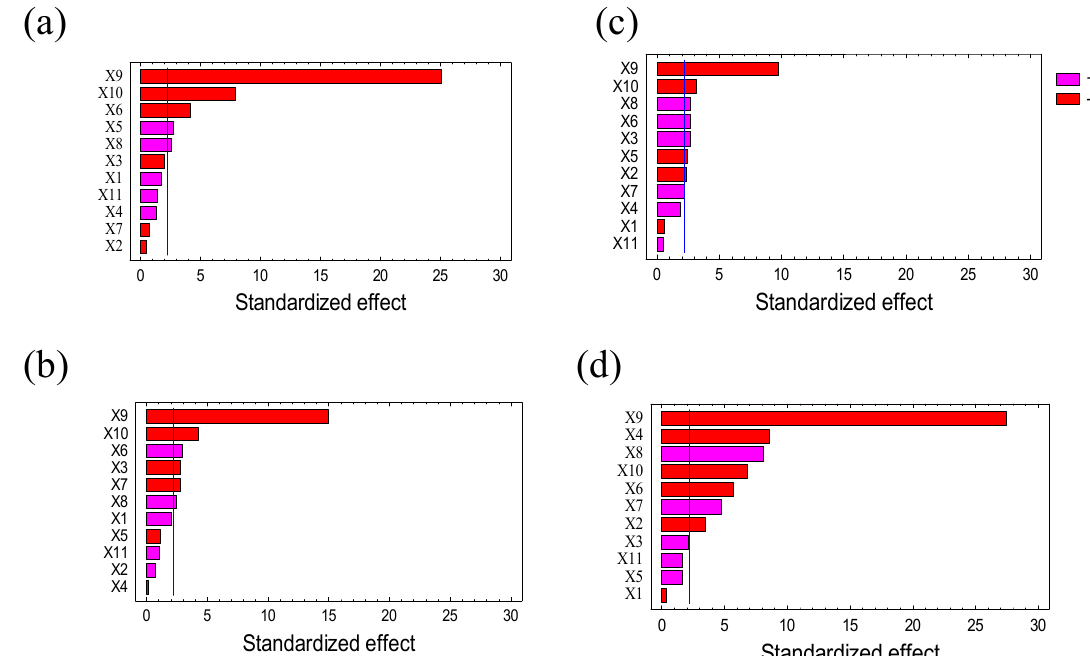
Figure 1. Standardized Pareto graph showing effect of the type of solvent, X1; the composition of solvents mixture, X2; the ratio of sample/solvent, X3; the concentration of Urea, X4; the extraction temperature, X5; the extraction time, X6; stirring speed, X7; pH, X8; type of salt, X9; concentration of salt, X10; and centrifugation speed, X11 on: ( a , b ) concentration of protein and ( c , d ) inhibition of amylase activity for Julius and Ponticus, respectively. The blue vertical line indicates the limit of the standardized effect whose values are significantly different from zero at the 95.0% confidence level. The pink color shows that the parameter has a positive effect and the red color a negative effect on the experimental response.